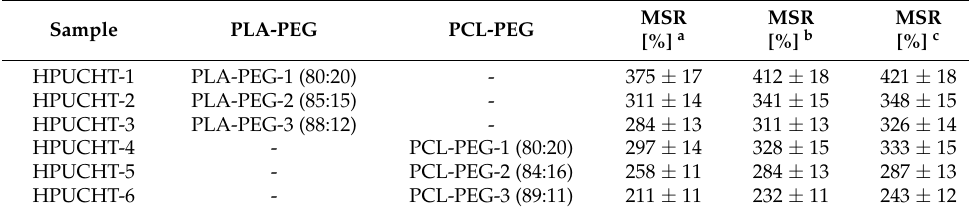
Table 2. Characterization of